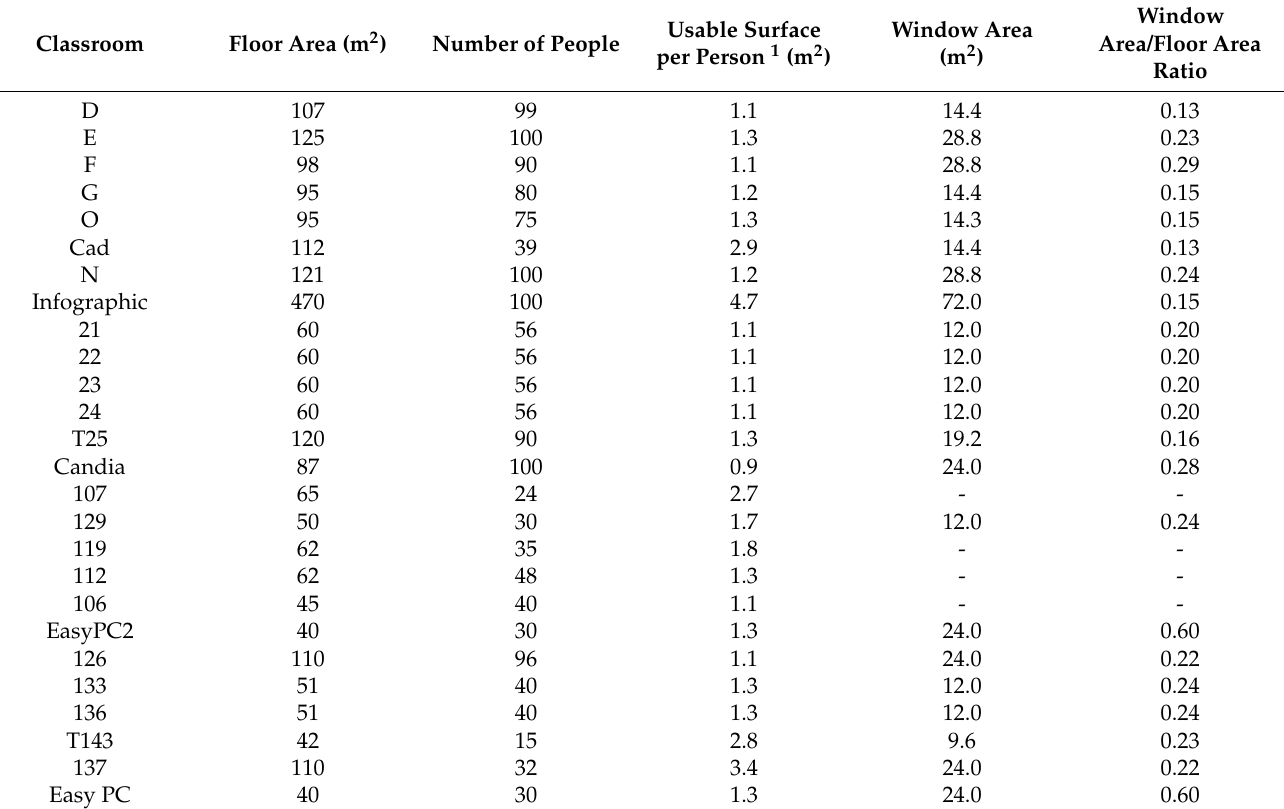
Table 1. Main parameters characterizing investigated